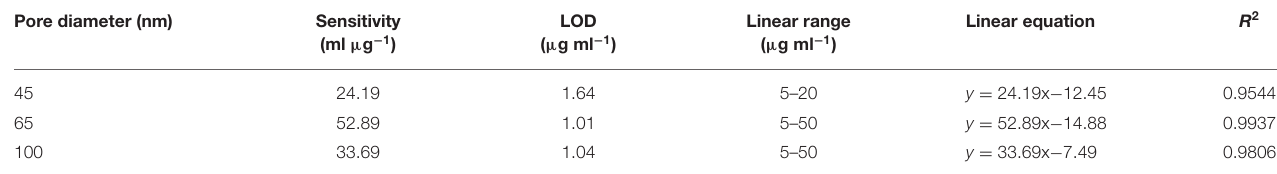
FIGURE 3 | (A) DPVs for increasing concentrations of KLH-conjugated Flii peptide in PBS for immunosensors prepared with FnAb-modified membranes of 65nm pore diameter; (B) dose response curves for KLH-conjugated Flii peptide detection using Flii and control biosensors fabricated with membranes of average pore diameter of 45, 65, and 100nm; (C) dose response curves obtained by using Flii and control biosensors fabricated with 65 nm-pore diameter membranes for KLH-conjugated Flii peptide detection in PBS and DMEM medium. Error bars were calculated from three independent experiments. Control sensors were prepared under the same conditions as the Flii biosensors but using non-specific antibodies. TABLE 1 | Comparison of the sensing performance of different immunosensors for detection of Flii conjugate in PBS (calculated based on the response curve in Figure 3B ). Pore diameter